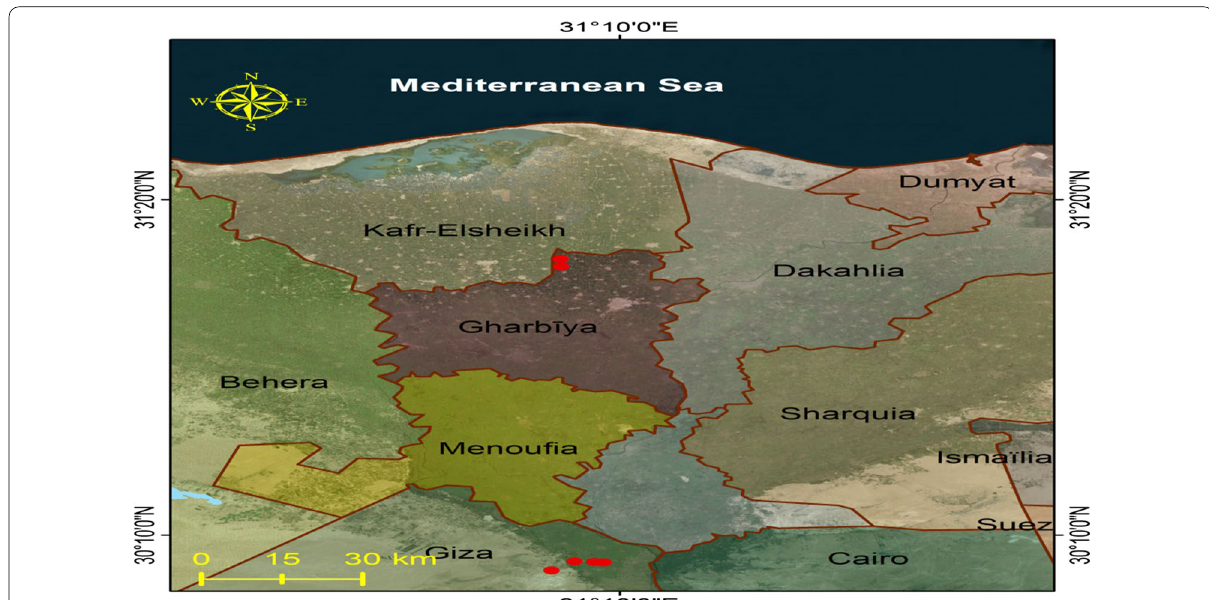
Fig. 1 Map representing the location of soil samples in the different investigated